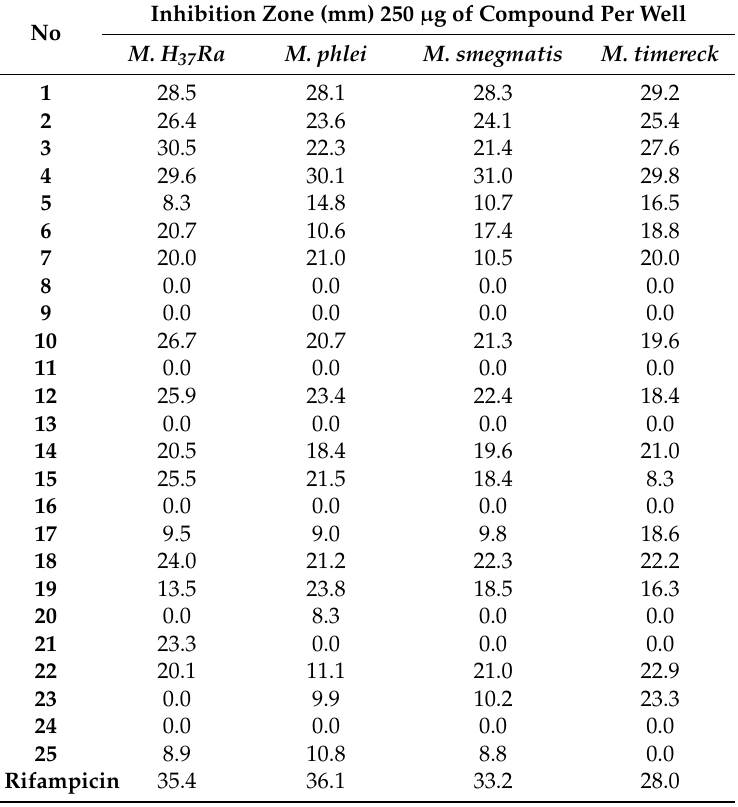
Table 3. Inhibition zone for tested compounds (250 µ g of compound was used per